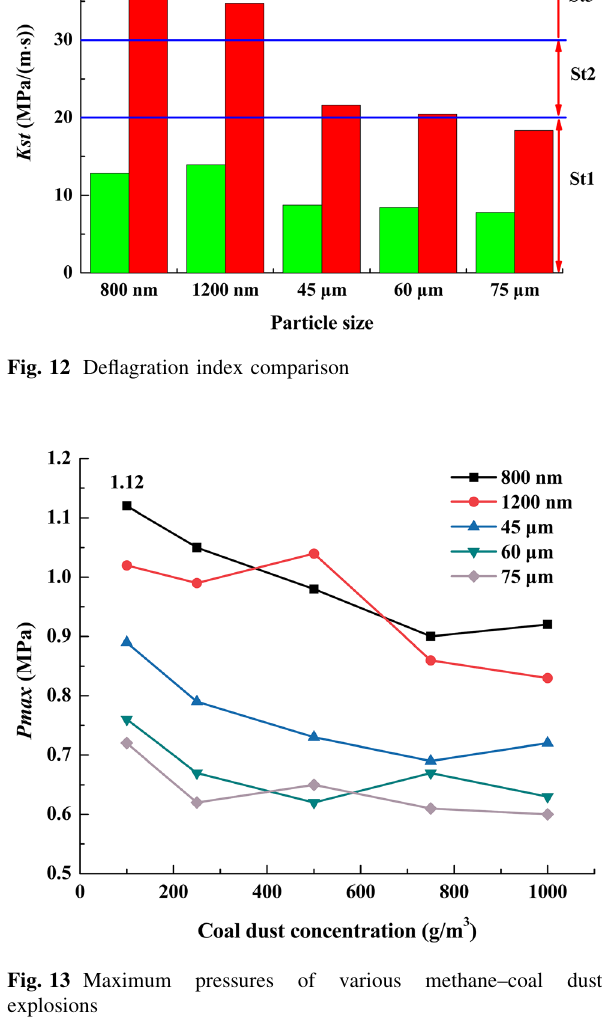
Fig. 11 Comparison of maximum rates of pressure rise